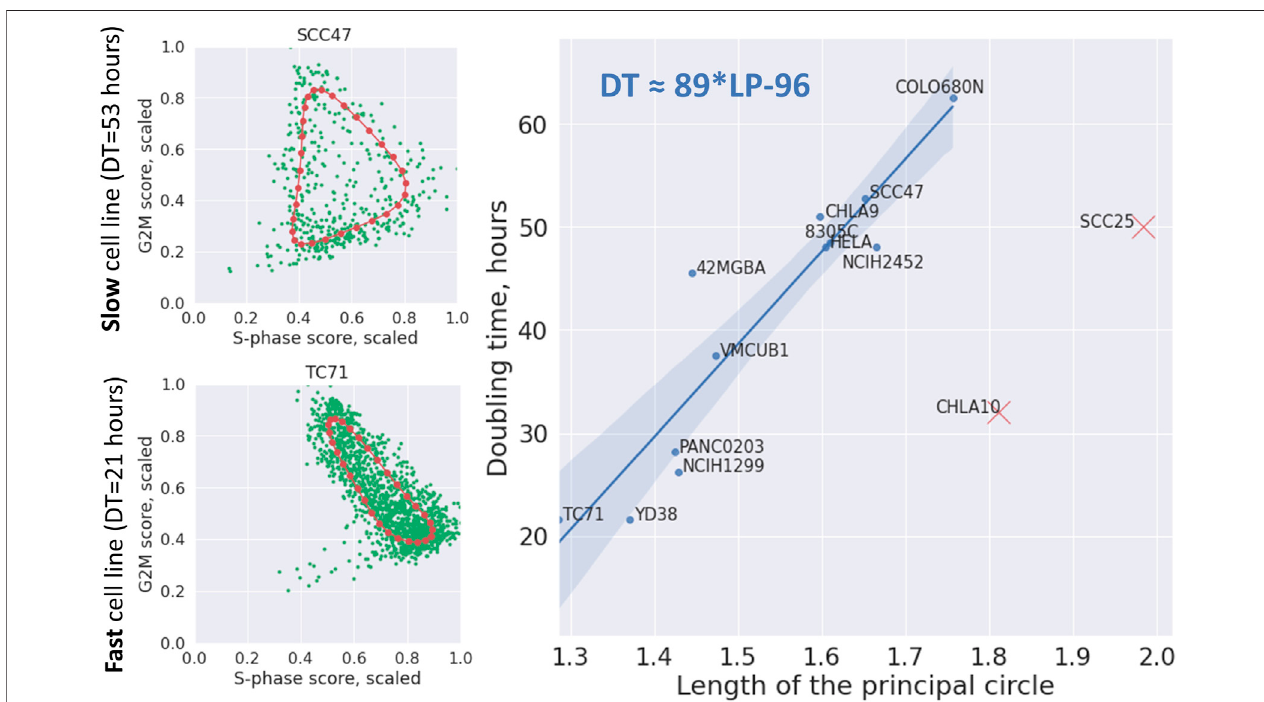
FIGURE 8 | Dependence of cell line doubling time (DT) on the length of the principal circle (LP) approximating the cell cycle trajectory in the 2D plane of scaled (divided by the maximum value) S-phase and G2M scores. On the left two examples of principal circles are shown in red, and cells in green. On the right the linear regression line withcon fi dence intervals is shown connecting thelength ofthe principal circle with cell linedoubling time (Pearson correlation 0.931, p -value (cid:1) 10 – 5 ). The regression formula is shown on the plot in top left corner. Two cell lines indicated by red crosses were eliminated from the regression as evident